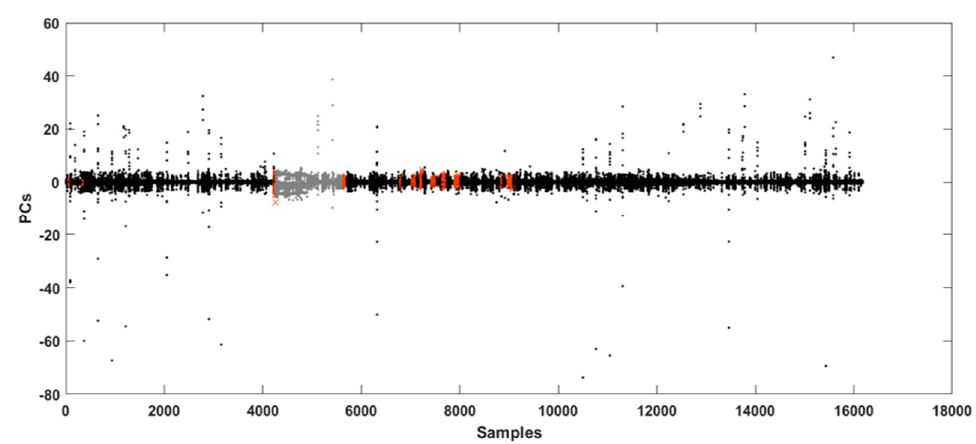
Figure 12. Results of the AAD + ADP algorithm (extruder-M2).